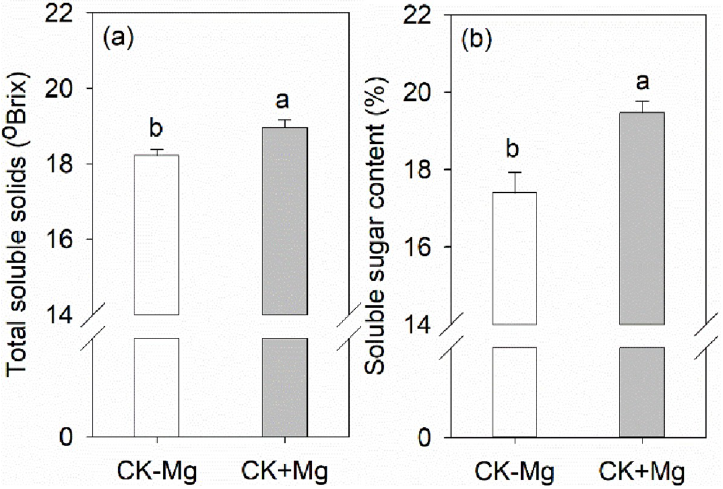
Fig 7. (a) Total soluble solids and (b) soluble sugar content in banana fruits. Plants grown in the control were amended with Mg solution (CK+Mg) or without Mg solution (CK-Mg) for 30 days. Values are means ± SE (n = 3). Different lowercase letters above the bars denote significant differences between CK-Mg and CK+Mg ( P <